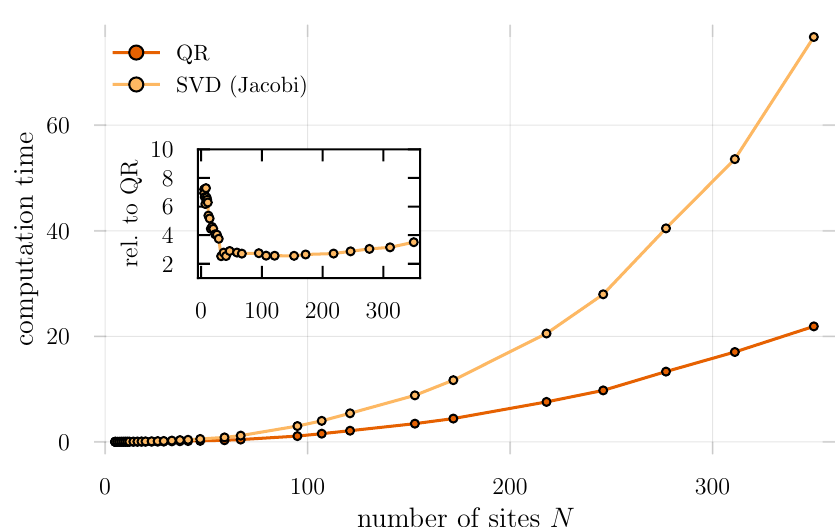
Figure (7) Efficiency of the time-displaced Green’s function obtained from sta- bilized computations using the QR decomposition in combination with the inversion scheme inv_sum_loh , Eq. (29) and the Jacobi SVD paired up with the regular in- version scheme inv_sum , Eq. (28). Measurements are taken over multiple runs at τ = β/ 2 = 20. The inset show the slowdown of the Jacobi SVD relative to the QR based